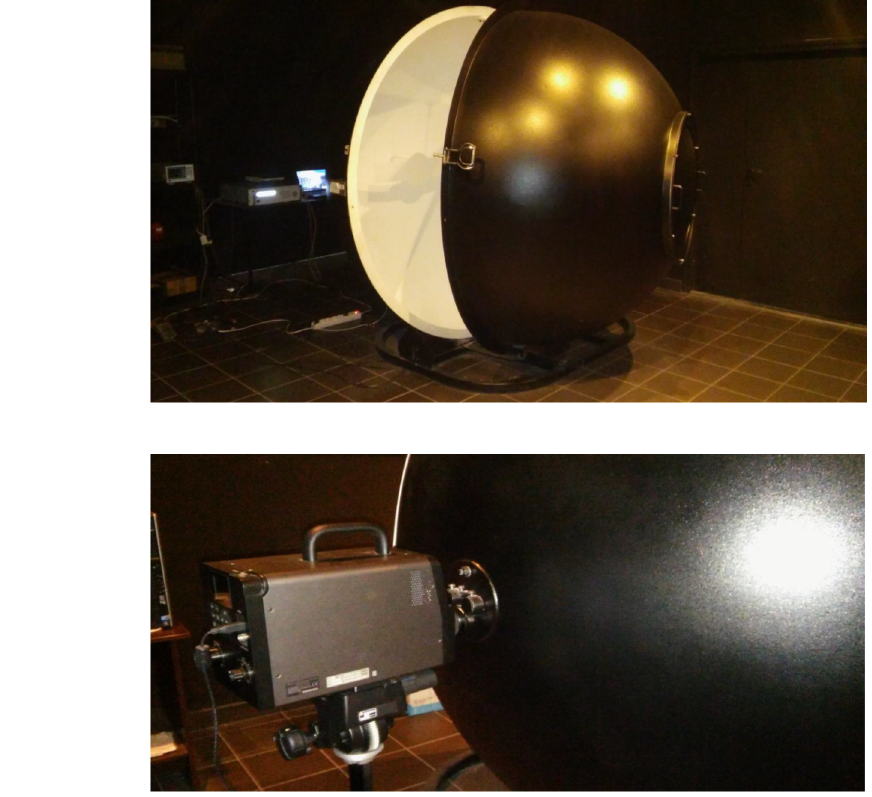
Figure 12. Laboratory stand for measuring the lighting parameters of the LED panel: ( a ) integrating sphere with a diameter of 2 m; ( b ) CS-2000 spectroradiometer. Table 5. The results of simulations and real measurements.